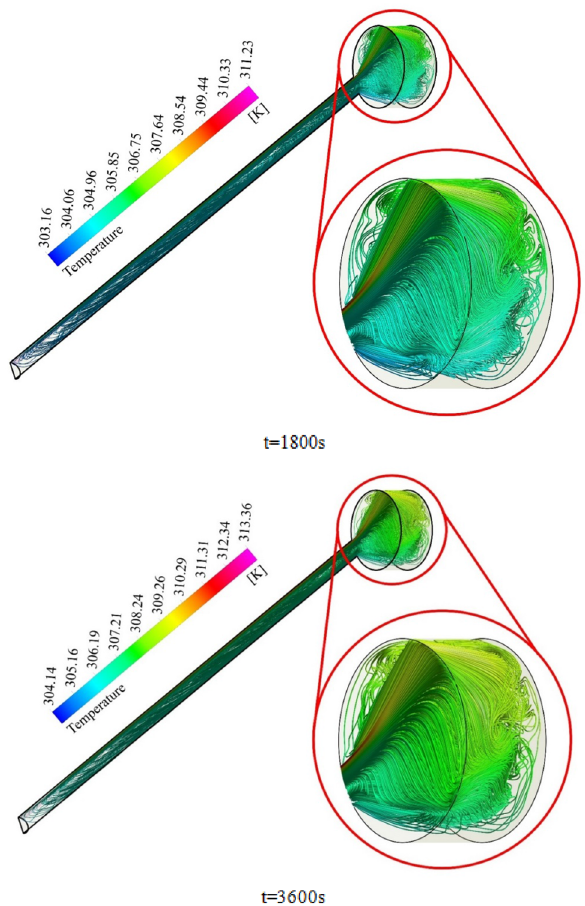
Figure 9. Illustration of temperature for nanofluid.